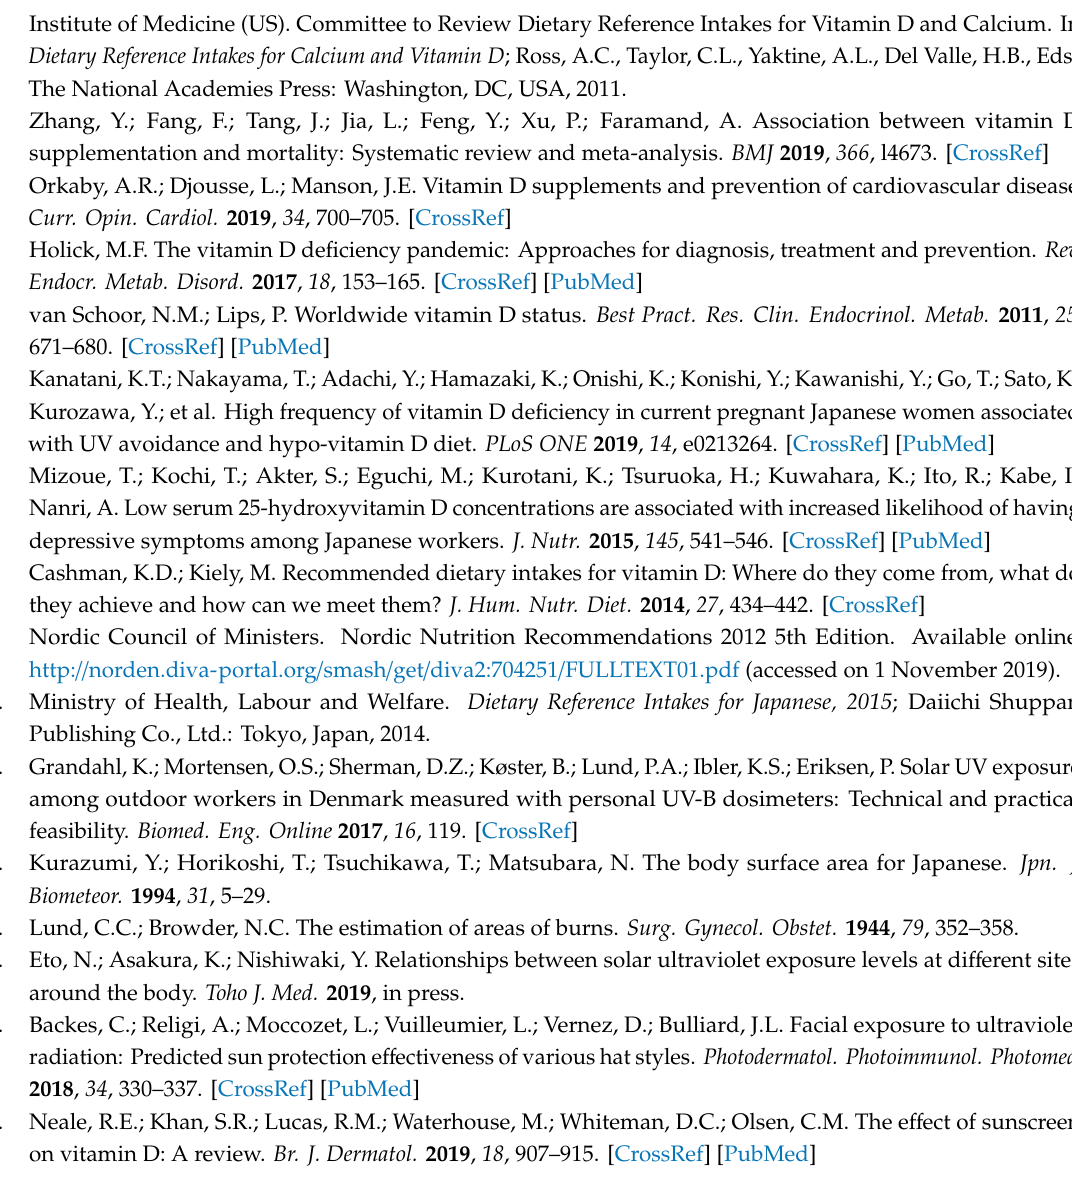
Table S1: Di ff erences between age groups in vitamin D intake, food intake, and UV